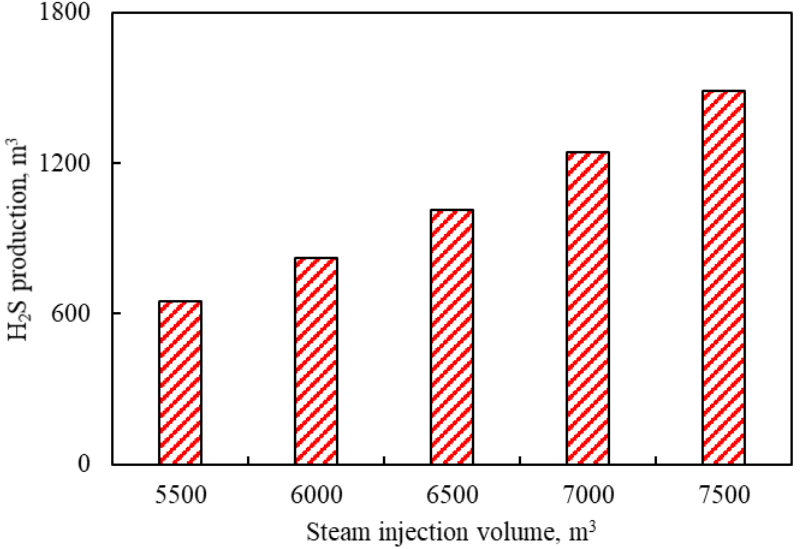
Figure 12. Effects of steam volumes on H 2 S production.